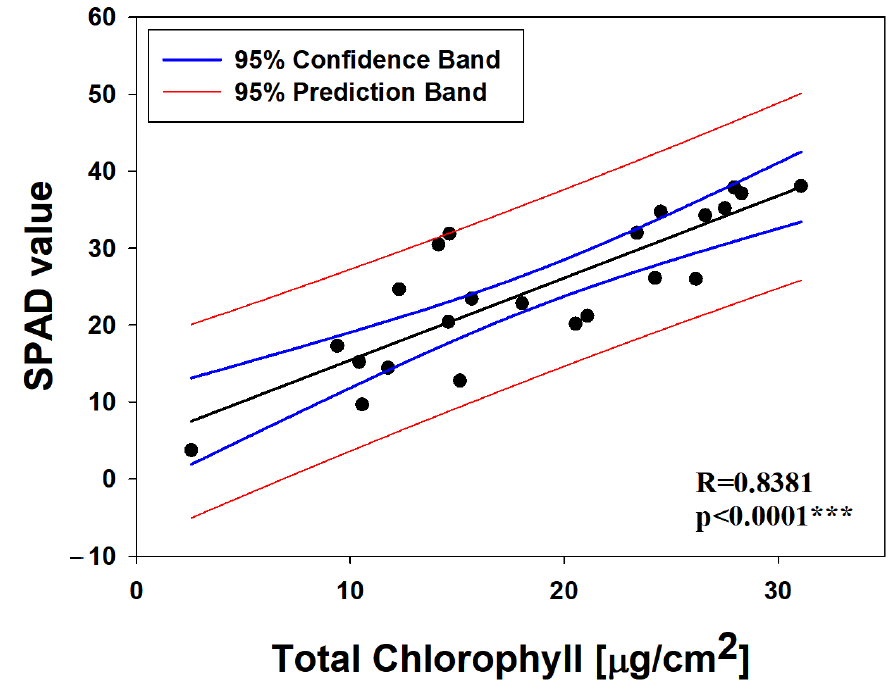
Figure A2. Field plot description for the retransplanted rice. LT, SE, and B indicate the growth stages late tillering, stem elongation, and booting, respectively.